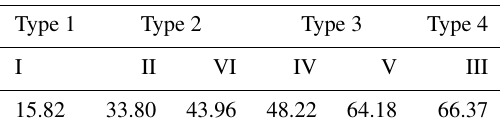
Table 6. AREs of the 16 members of the physical ensemble for the four types of storm events